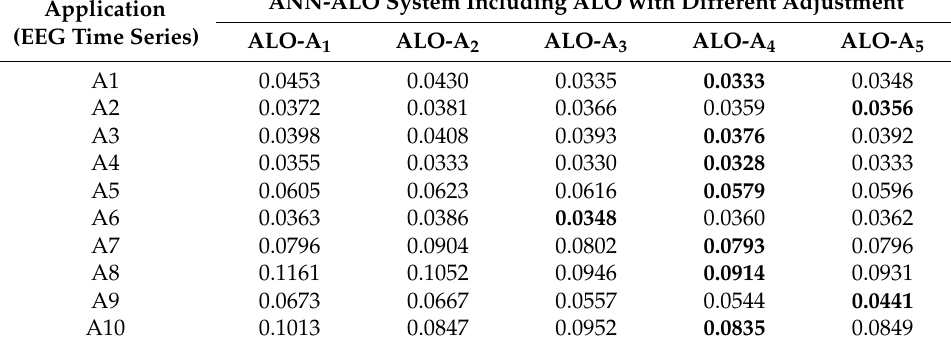
Table 6. Mean squared error (MSE) values calculated for each EEG time series (Figure 5), via different ANN–ALO